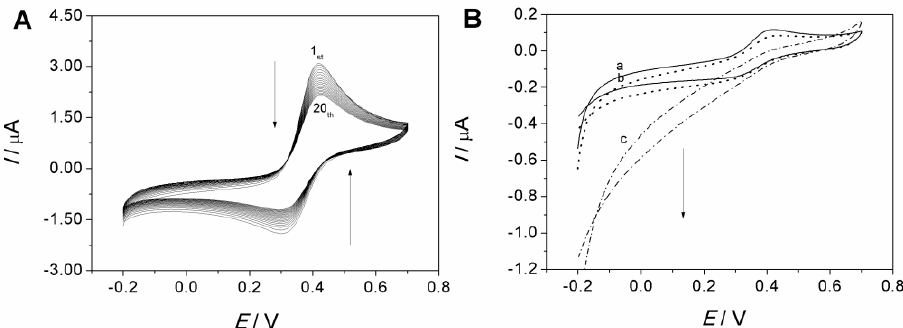
Figure 5. ( A ) Twenty consecutive CVs obtained on MCF-IL-Fe(CN) 6 3− /PVA electrode in 0.1 M HCl + 0.1 M KCl solution, scan rate: 100 mV s −1 ; ( B ) CVs obtained on acid-pretreated